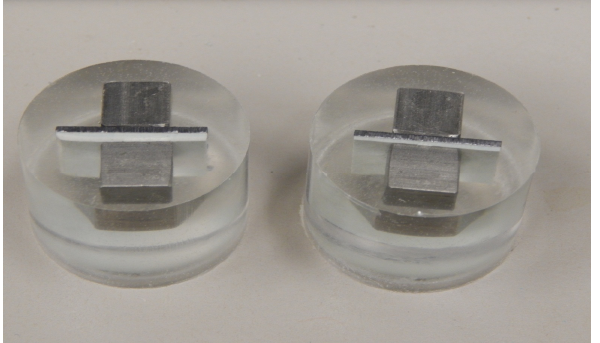
Figure 1. Samples embedded in resin.